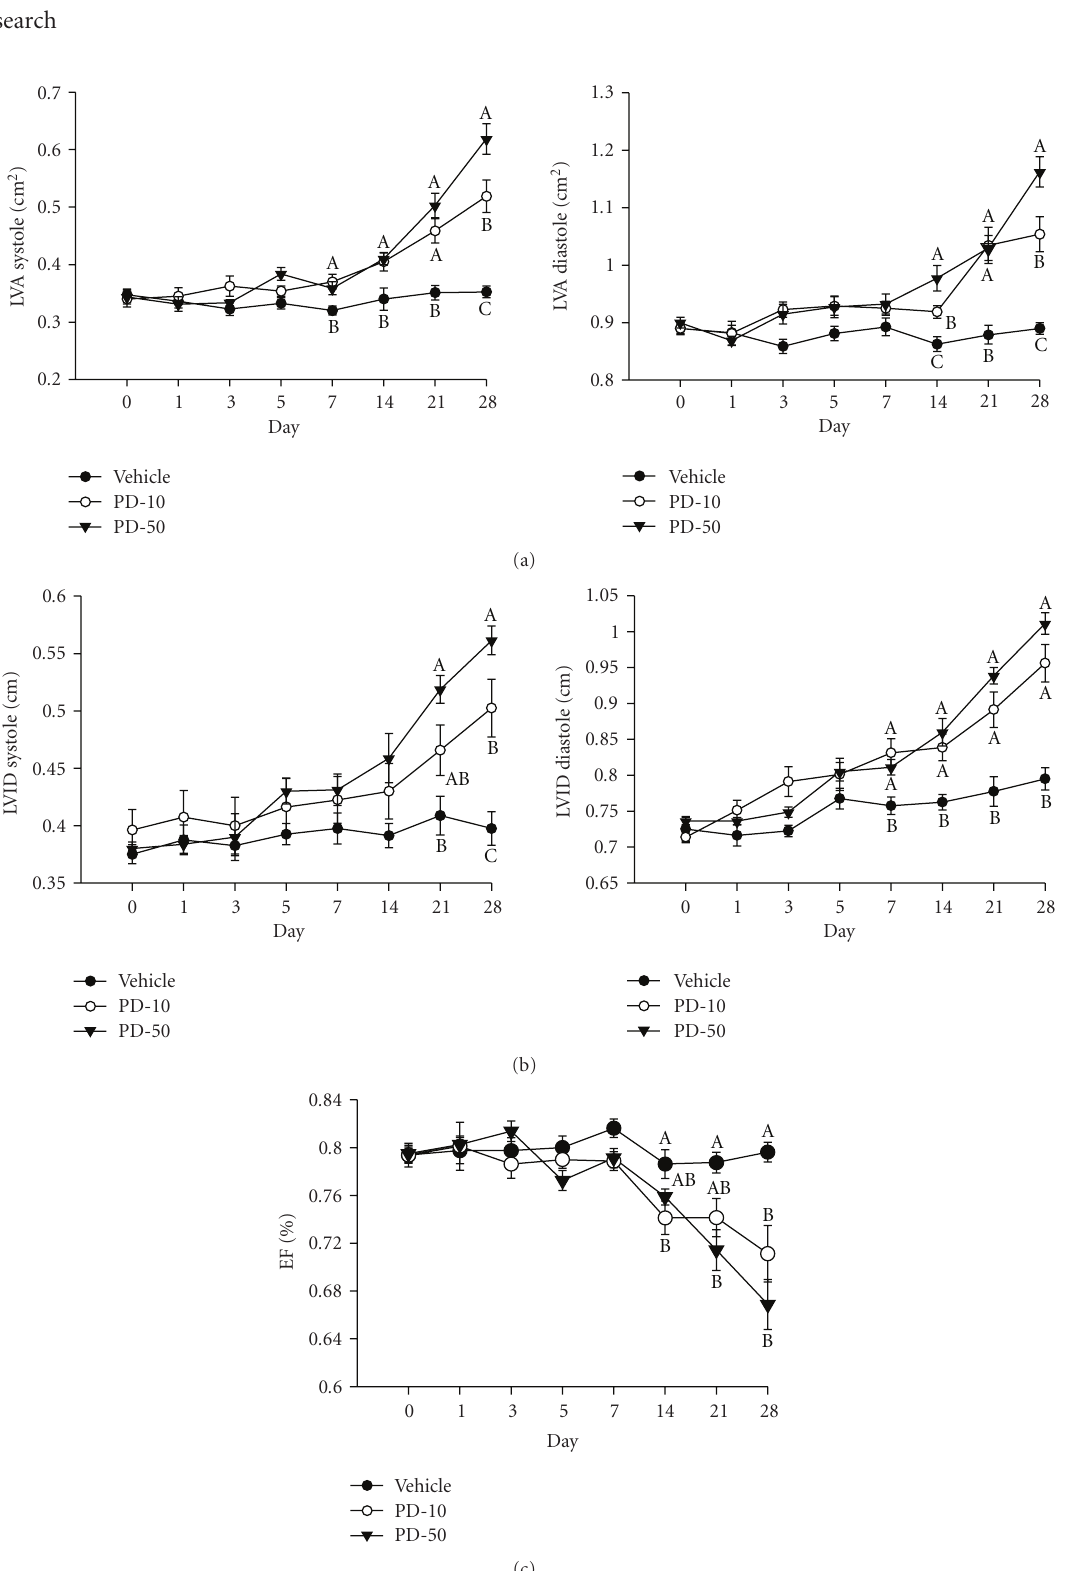
Figure 6: Left ventricular expansion and ejection fraction in PD168 treated rats. (a) Left ventricular area (LVA) in systole and diastole; (b) Left ventricular internal dimension (LVID) in systole and diastole in normal male SD rats chronically treated with vehicle (VEH), PD168 at the dose of 10 mg/kg · body weight (PD-10) or 50 mg/kg · body weight (PD-50), ( n = 10/treatment group). Means were compared using one-way ANOVA followed by Holm-Sidak test. Data are represented as means ± SEM. Di ff erent letters represent significant di ff erences between the groups with “A” being highest mean and “AB” not di ff erent from “A” or “B” and so forth ( p < 0 . 05 was considered